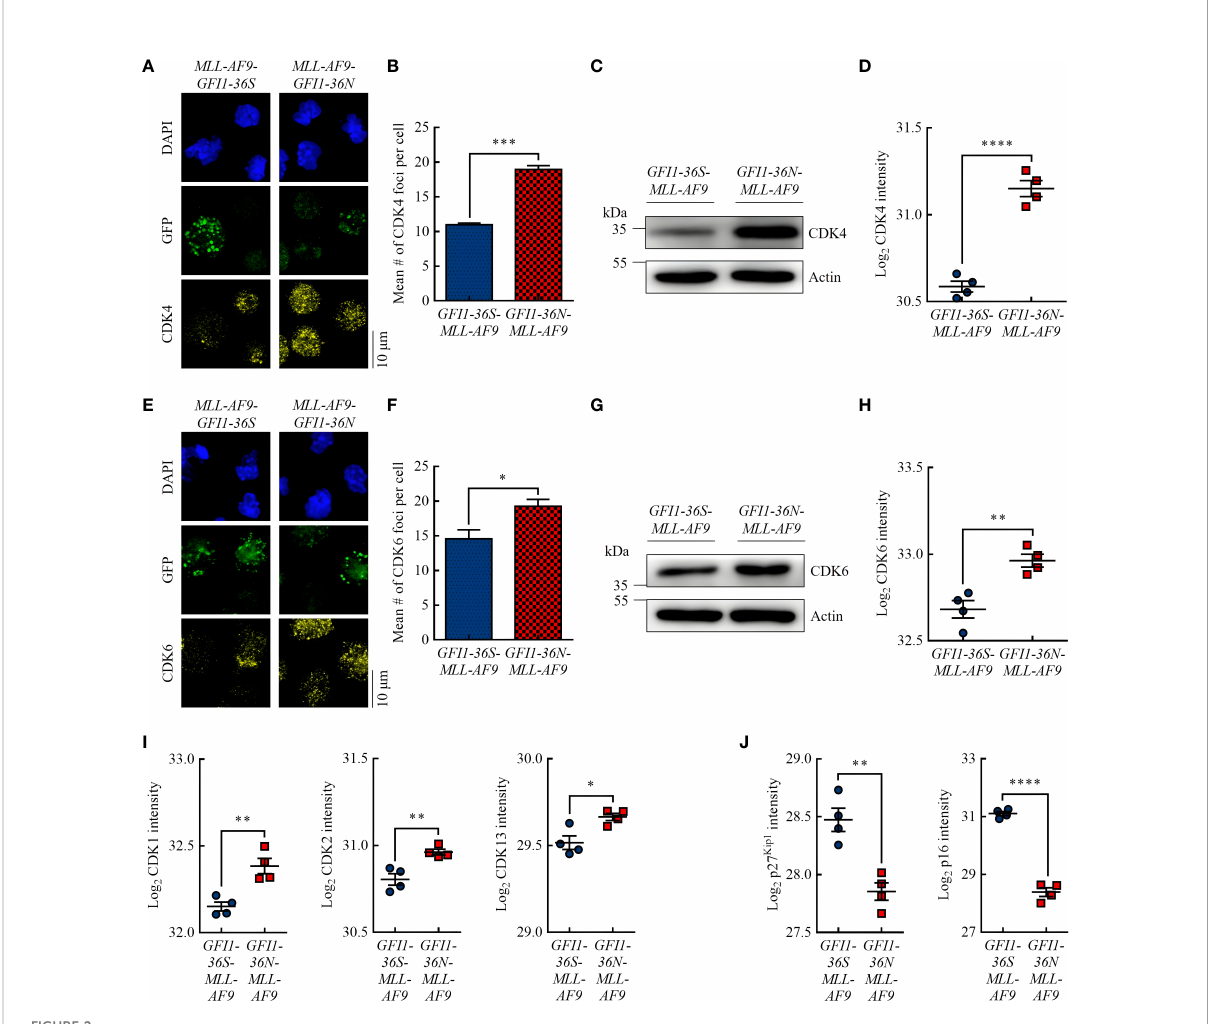
FIGURE 2 GFI1-36N leukemic cells are associated with higher protein levels of the cell cycle kinases CDK4 and CDK6. (A) CDK4 foci. Blue (DAPI) = nucleus, green (GFP) = leukemic cells, yellow (AF555) = CDK4. (B) Quanti fi cation of CDK4 foci. (C) CDK4 protein level detected by immunoblotting. (D) CDK4 protein intensity detected by MS-based proteomics. (E) CDK6 foci. Blue (DAPI) = nucleus, green (GFP) = leukemic cells, yellow (AF555) = CDK6. (F) Quanti fi cation of CDK6 foci. (G) CDK6 protein level detected by immunoblotting. (H) CDK6 protein intensity detected by MS-based proteomics. (I) CDK1, CDK2, and CDK13 protein intensities detected by MS-based proteomics. (J) P27 Kip1 and p16 protein intensities detected by MS-based proteomics. Mean ± SEM ( n = 3 – 4); p * ≤ 0.05, p ** ≤ 0.01, p *** ≤ 0.001, p **** ≤